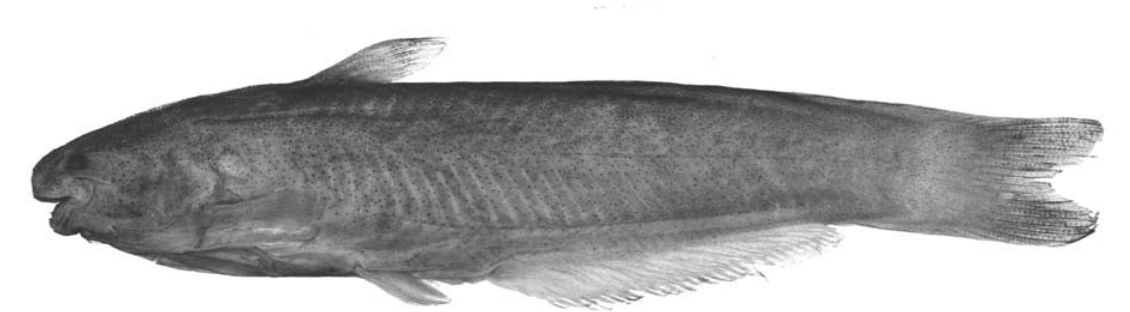
Fig. 11. Cetopsis amphiloxa, holotype of Hemicetopsis amphiloxus , FMNH 56519, 65 mm SL; Colombia, Choco, río Patía basin, creek near San Lorenzo (approximately 2°13’N,